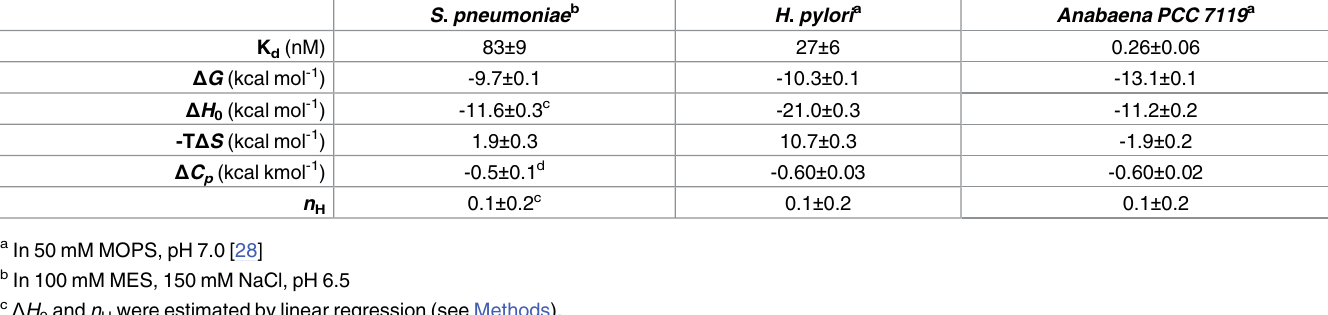
Table 2. Apoflavodoxin/FMN binding